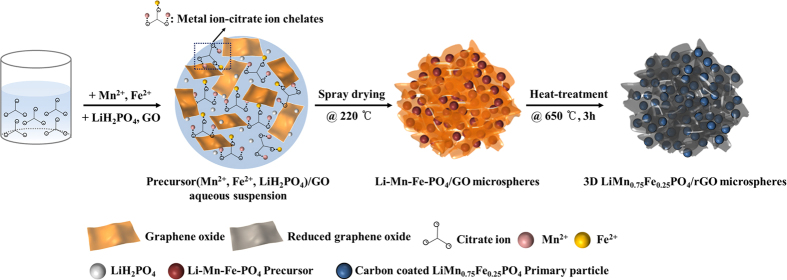
Schematic illustration showing the formation of the 3D LiMn0.75Fe0.25PO4/rGO microspheres.